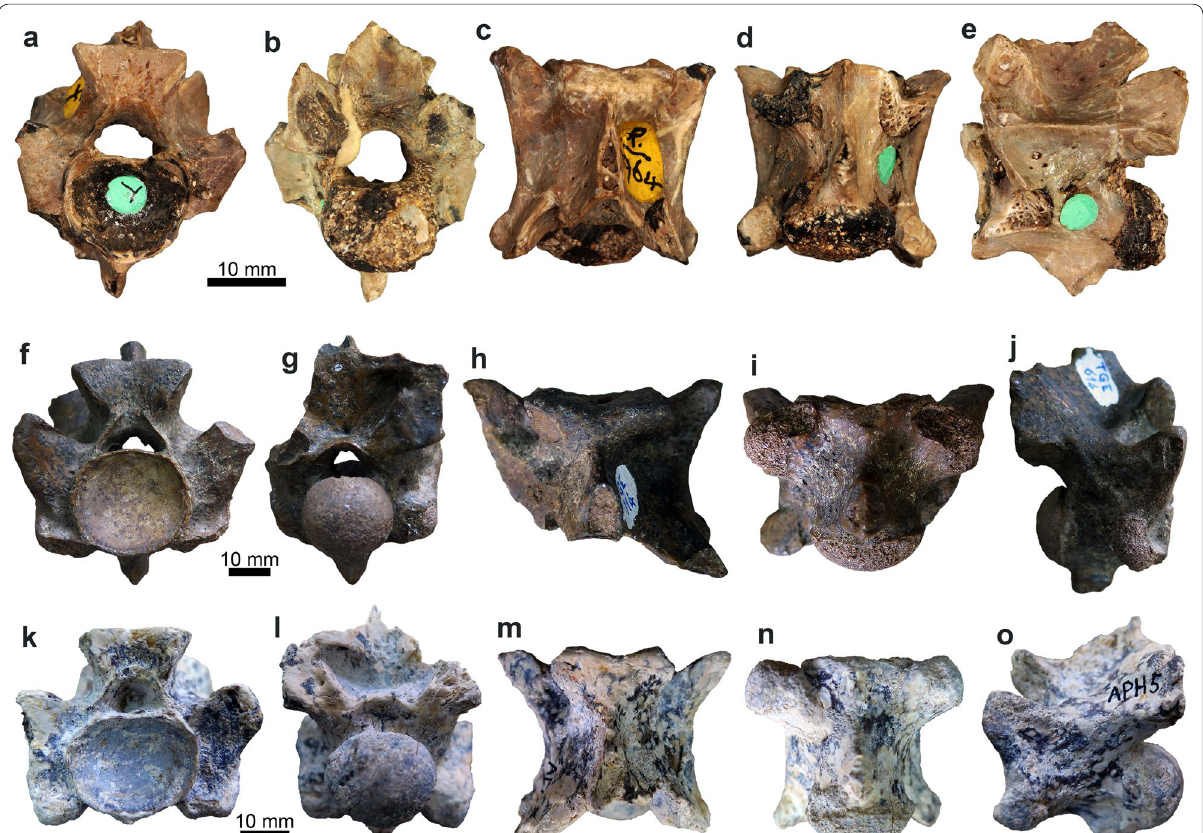
Fig. 10 Type specimens of all named African species of Palaeophis : a–e holotype trunk vertebra (NHMUK PV R 4964) of Palaeophis africanus from the middle Eocene of Oshosun Formation, Nigeria, in anterior ( a ), posterior ( b ), dorsal ( c ), ventral ( d ), and left lateral ( e ) views; f–j holotype trunk vertebra (MNHN.F. TGE615) of Palaeophis colossaeus from the early–middle Eocene of the Tamaguélelt Formation, Mali, in anterior ( f ), posterior ( g ), dorsal ( h ), ventral ( i ), and right lateral ( j ) views; k–o holotype trunk vertebra (MNHN.F. APH5) of Palaeophis maghrebianus from the early Eocene of the phosphates of Djemaïa, Oulad Abdoun, Morocco, in anterior ( k ), posterior ( l ), dorsal ( m ), ventral ( n ), and left lateral ( o ) views. From